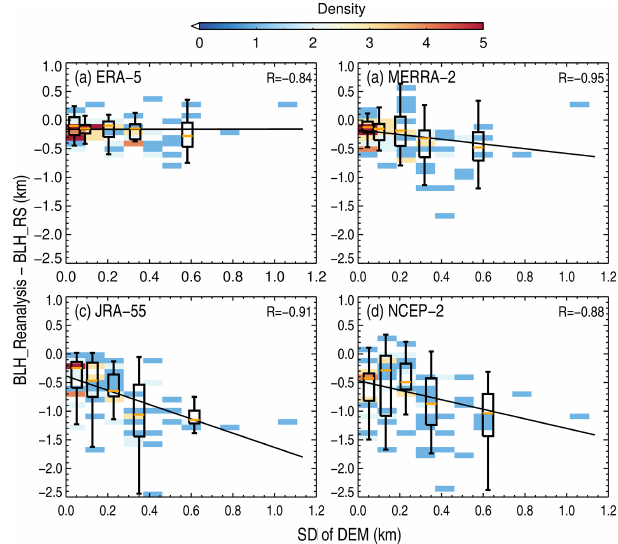
Figure 11. Density plots of the differences of BLHs between ra- diosonde and ERA5 (a) , MERRA-2 (b) , JRA-55 (c) , and NCEP- 2 (d) as a function of the SD of the DEM, for which the black lines denote the least-squares regression line. The box-and-whisker plots of the anomalies in BLH in five evenly intervals are overlaid in each panel, and the correlation coefficients are marked in the upper right corner of each panel. Note that all samples are collected from soundings that are launched in the afternoon, spanning from 13:00 to